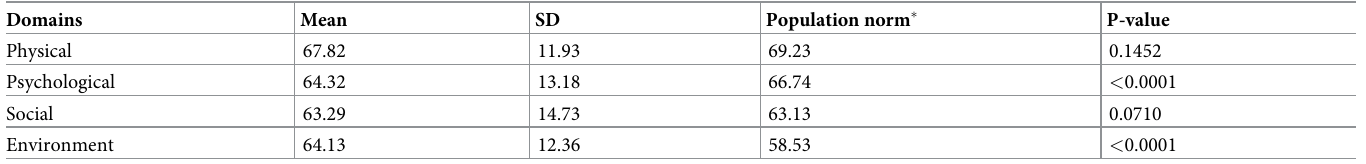
Table 4. Comparison between quality of life domains and population norm